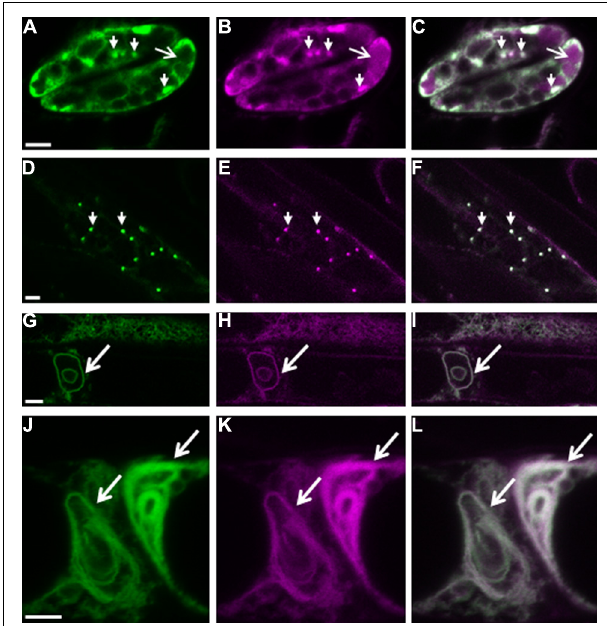
FIGURE 1 |Autophagy-dependent degradation ofAtTSPO. Confocal images of a mCherry-GFP-AtTSPO fusion stably expressed constitutively in transgenic Arabidopsis thaliana ; the green signal represents GFP fluorescence, magenta mCherry fluorescence, and the overlapping signal is shown as white in the merge images. Arrowheads in panels A–C indicate Golgi stacks in guard cells, and the arrow highlights mCherry fluorescence (but not GFP) in the vacuole. Panels D–F show imaging of the fluorescent chimera in a root cell, and the arrowheads indicate Golgi stacks. Panels G–I show the formation of autophagy bodies (arrow) in root cells after Concanamycin A treatment. Panels J–L show complex entangled membranes of autophagy bodies after Concanamycin A treatment. Scale bar is 5 μ m in A–I , and 2 μ m in J–L .